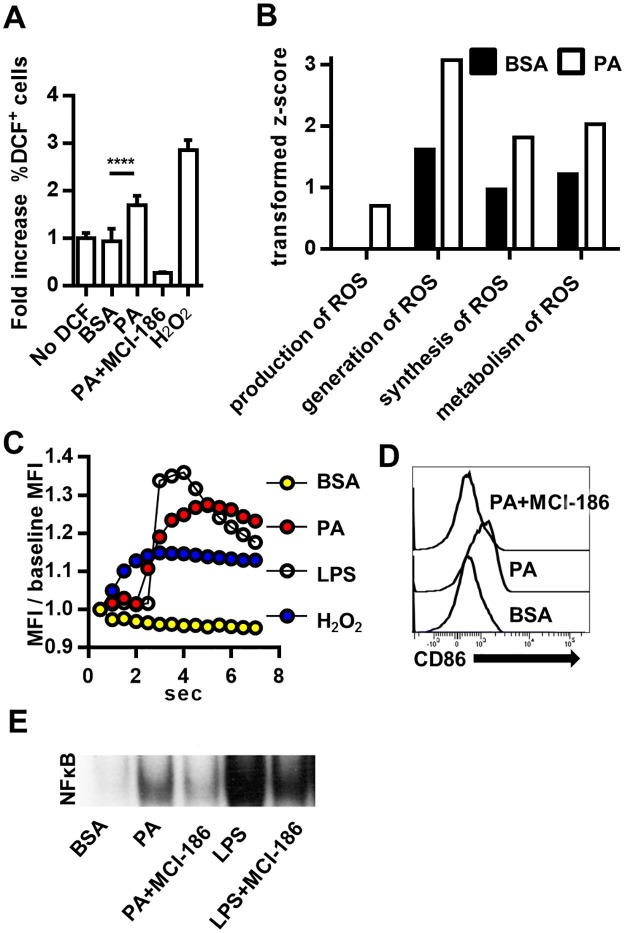
PA activation of MoDCs is regulated by ROS.(A) PA induces ROS in MoDCs. MoDCs were treated for 24hrs with PA. ROS was measured by DCF fluorescence and expressed as fold increase relative to MoDCs not incubated with DCF. The ROS scavenger MCI-186 was used as a negative control. N = 3. (B) Comparison of activation z-scores for cellular functions related to ROS production. After 24hr treatment, the DC proteome was assessed by mass spectrometry and protein changes analyzed using IPA. Transformed z-scores are displayed on the bar graph. The z-scores indicate the association of proteome changes with the indicated cellular functions in the MoDC after PA treatment. Non-transformed z-scores and p-values for association with cellular functions are in Supplement 4. (C) MoDCs were pre-incubated with the H2O2 probe PF6-AM. Upon addition of the indicated stimuli, PF6 fluorescence was detected by rapid-fire snap shots. The mean fluorescence intensity (MFI) of PF6 was normalized to baseline and plotted against time. (D) PA-induced MoDC activation is attenuated by MCI-186. MoDCs were treated with 300μM PA for 36 hrs. Cells were stained and analyzed by flow cytometry. MoDCs were gated by the phenotype (CD11chi) and histograms for CD86 were plotted. Data is representative of three separate experiments. (E) PA-induced activation of NF-κB is ROS dependent. MoDCs were treated with 300μM PA+/- MCI-186 or LPS+/- MCI-186 for 3hrs and analyzed by EMSA.